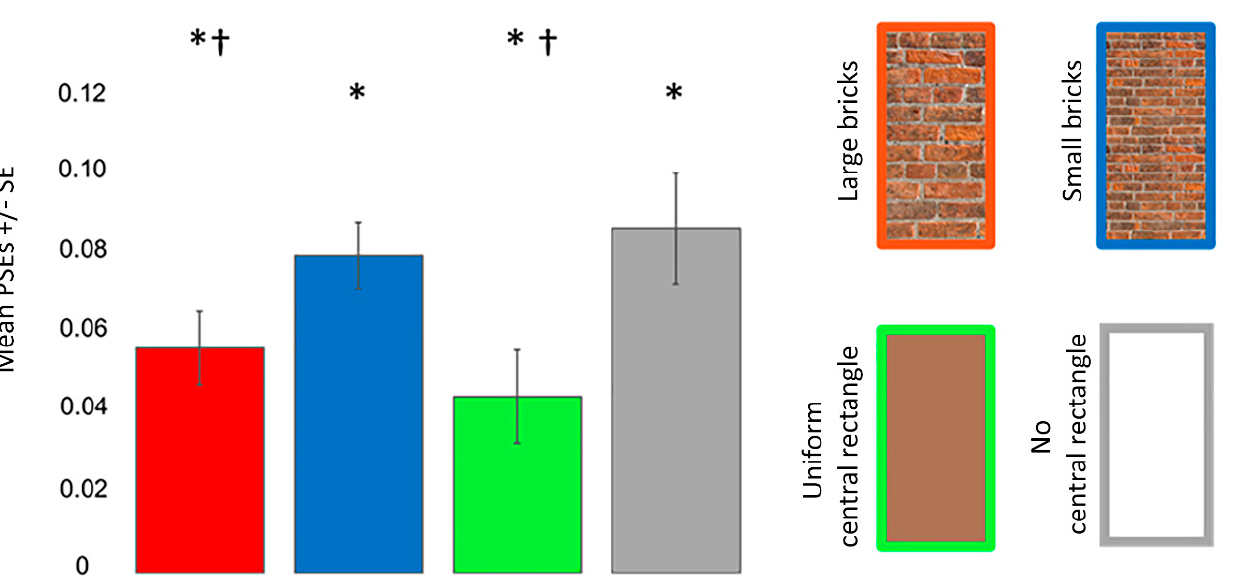
Figure 8. Mean bistability widths for the different Poggendorff stimuli in experiment 2. The dagger (†) denotes a difference from the no central rectangle condition at p < 0.050 after correcting for mul- tiple comparisons using the Bonferroni method. Mean bistability widths were computed by sub- tracting P = 0.25 from P = 0.75. Error bars denote standard errors for within-subject contrasts as described by O ′ Brien and Cousineau [22].